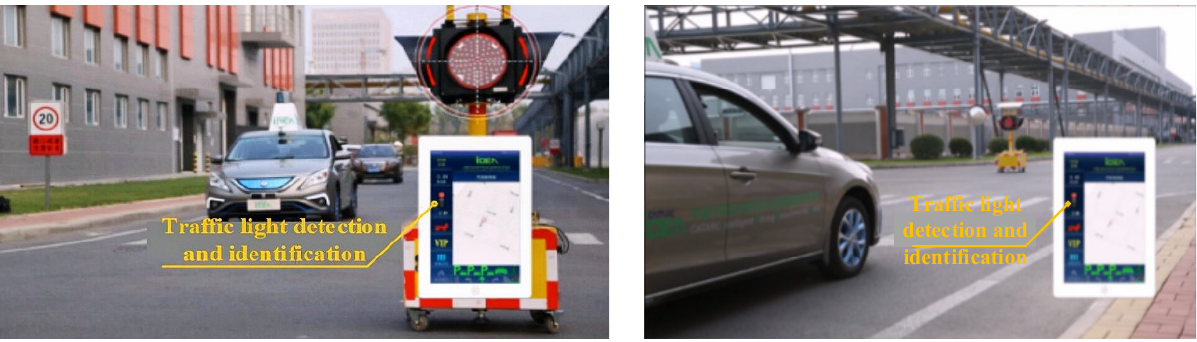
Figure 23. Traffic lights recognition based on V2X.